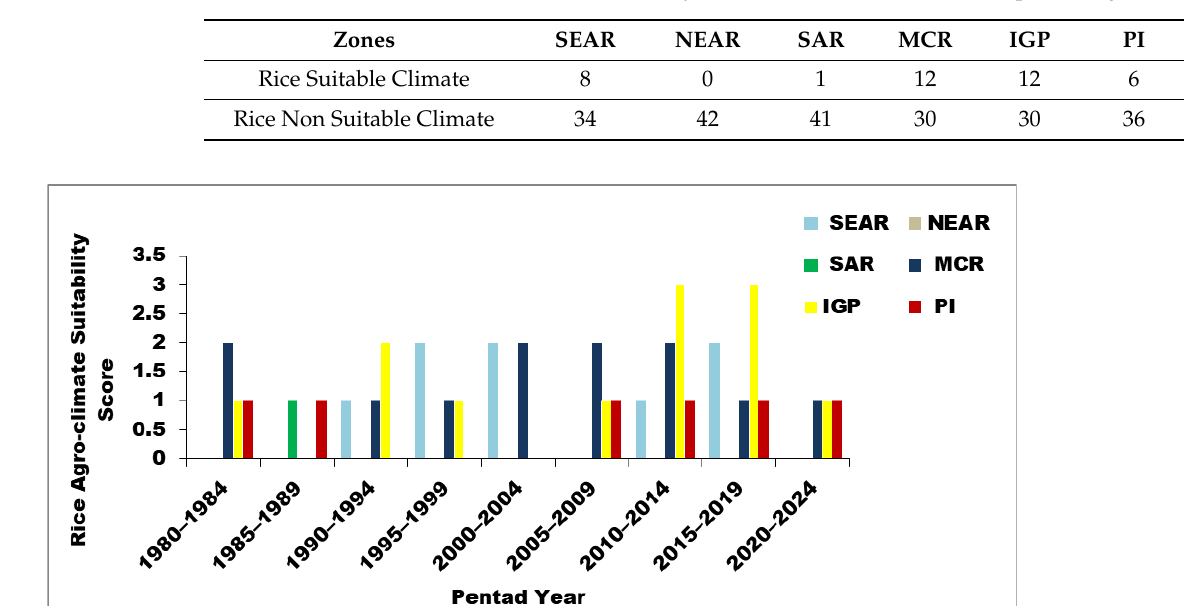
Figure 5. Rice suitability score in various pentad years from 1980 to 2021 for various rice growing regions of world. Table 13. Rice suitable climate score for various rice growing regions of the world in pentad years from 1980 to 2021.